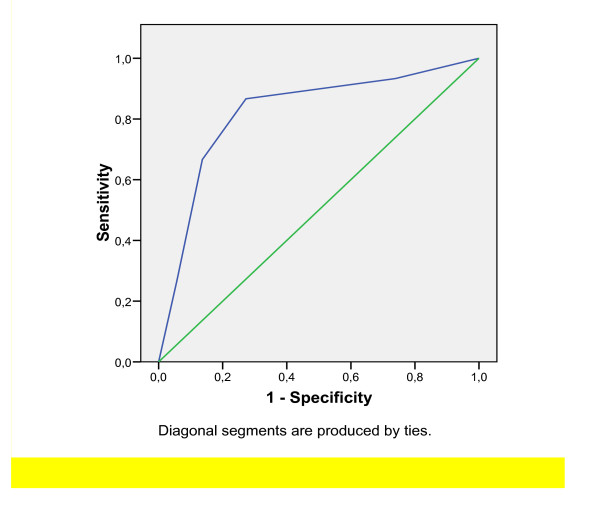
Simple steatosis plus non-alcoholic steatohepatitis (NASH) with fibrosis stages 0-2 vs. NASH with fibrosis stages 3-4.